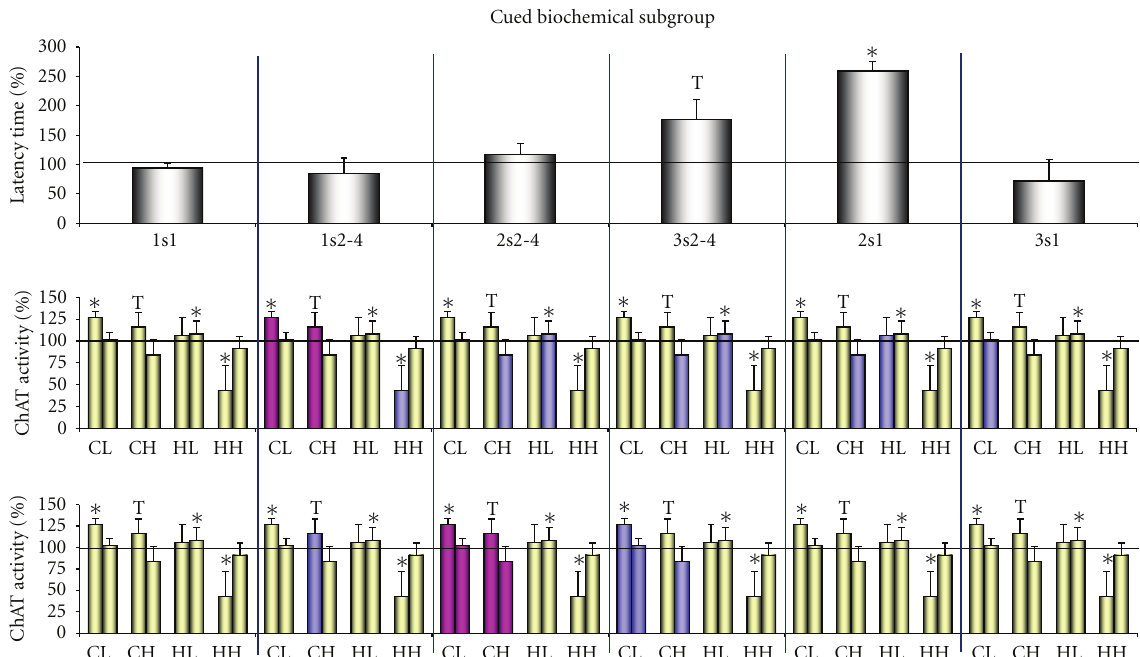
Figure 5: 2VO induced changes in behavioral performance and ChAT activity in the key cholinergic populations in the spatial cued biochemical subgroup ( n = 4). 1s2, 1s3-4, 2s2–4, 3s2–4, 2s1 and 3s1, the same forms of cognition as in Figure 1. Behavioral performance was expressed as percentage of latency time compared to their control values (100%) as in Figure 4. CL, CH, HL, HH, the same pairs of the subfractions as in Figure 2. Values of ChAT activity in the subfractions are identical to ones in Figure 2-cued, and were duplicated under the each form of cognition as in Figure 4. Blue and violet bars the same as in Figure 4. In the middle row were marked correlations between behavioral performance and ChAT activity in the control rats (correlations correspond to Table 2, Sham-Cued). In the bottom row were marked correlations between behavioral performance and ChAT activity in 2VO rats (correlations correspond to Table 2, 2VO—Cued). ∗ , P < . 05 by the Fisher’s Exact test. See comments in Section